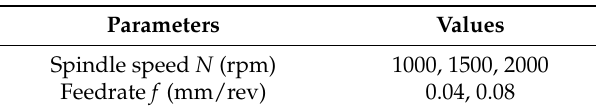
Table 1. Drilling parameters.